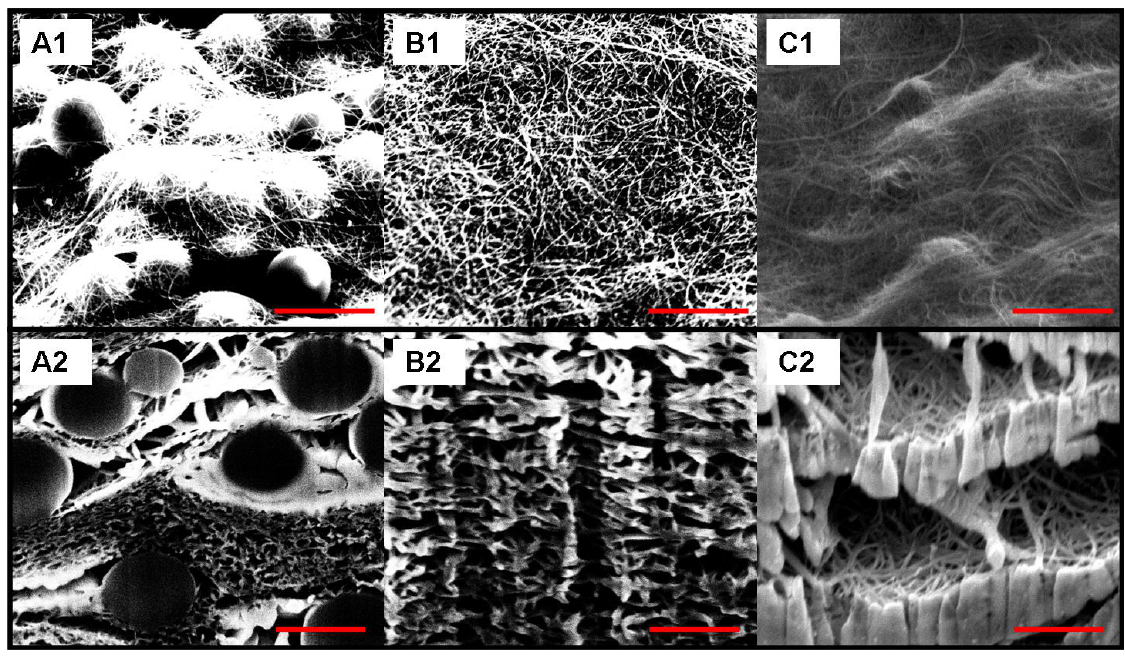
Figure 2. SEM images of BPs surface and cross sections for 1 μm poly-styrene bead reinforced BPs. Images A1 and A2 correspond to the composite after filtration of the bead/CNT suspension, while B1 and B2 were taken on samples after bead dissolution, and C1 and C2 on the bead/CNT composite after carbonization. The micrographs were taken at a tilt of 52°. The scale bars on the micrographs correspond to 1